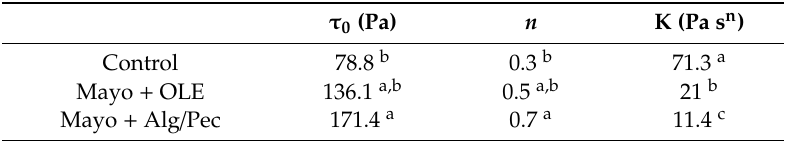
Table 2. Herschel–Bulkley viscosity parameters of the mayonnaise Table 2. Herschel – Bulkley viscosity parameters of the mayonnaise samples.